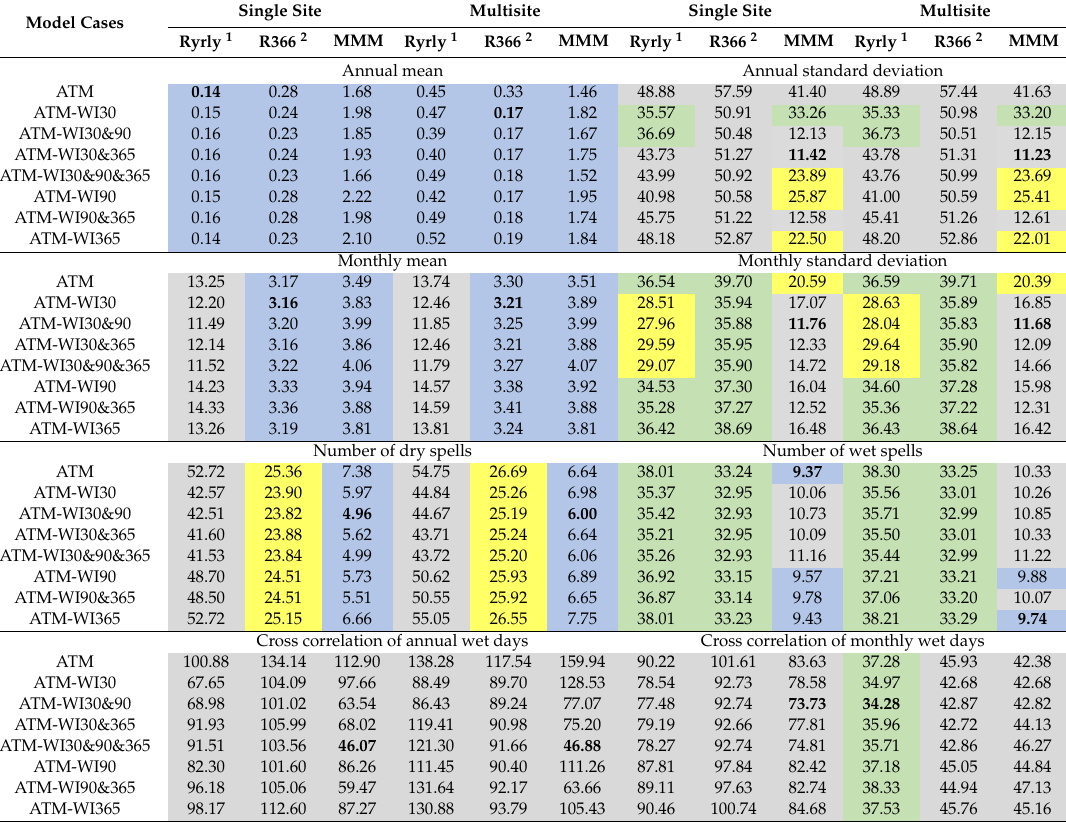
Table 1. Relative root mean square error (Rel. RMSE) of basic statistics for calibration time period. Single Model Cases